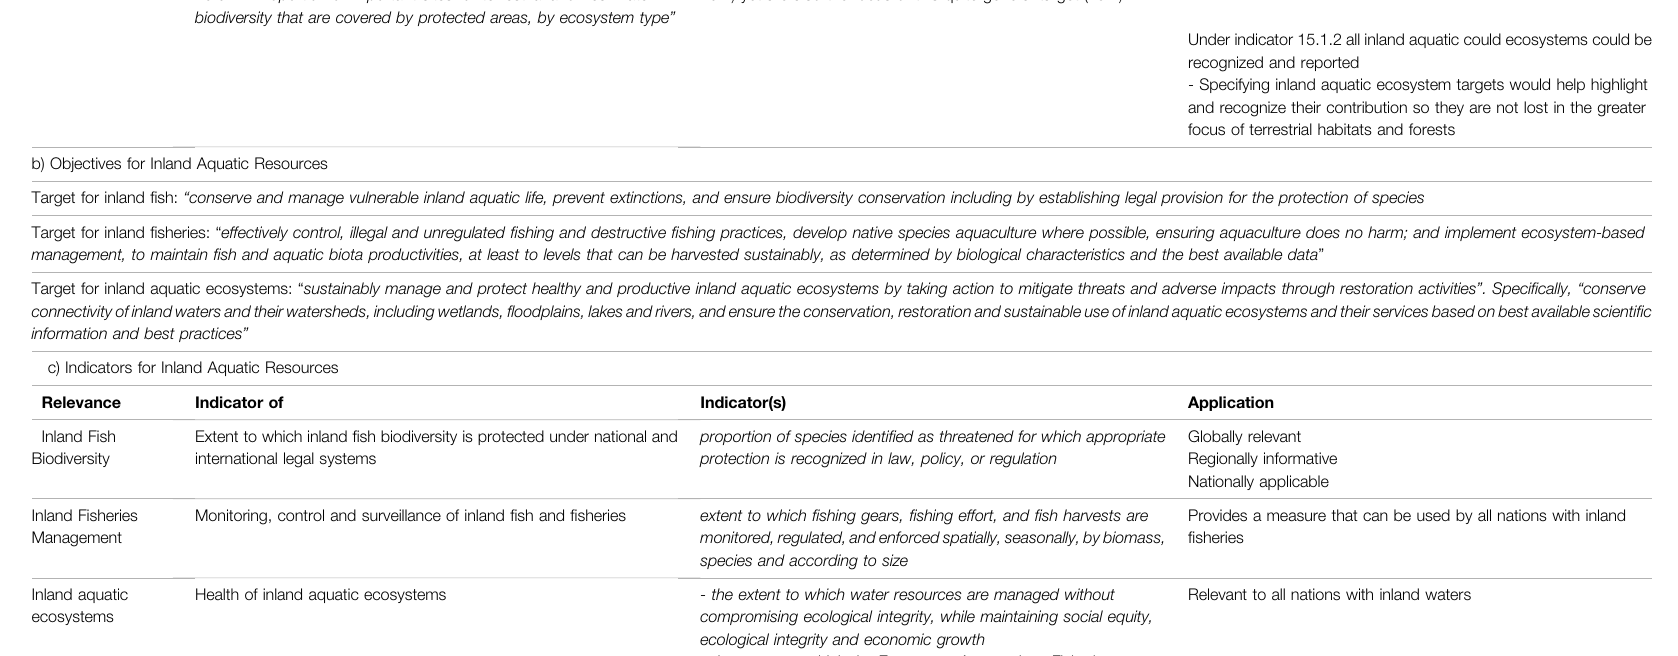
Globally relevant Regionally informative Nationally applicable Provides a measure that can be used by all nations with inland fi sheries Relevant to all nations with inland waters